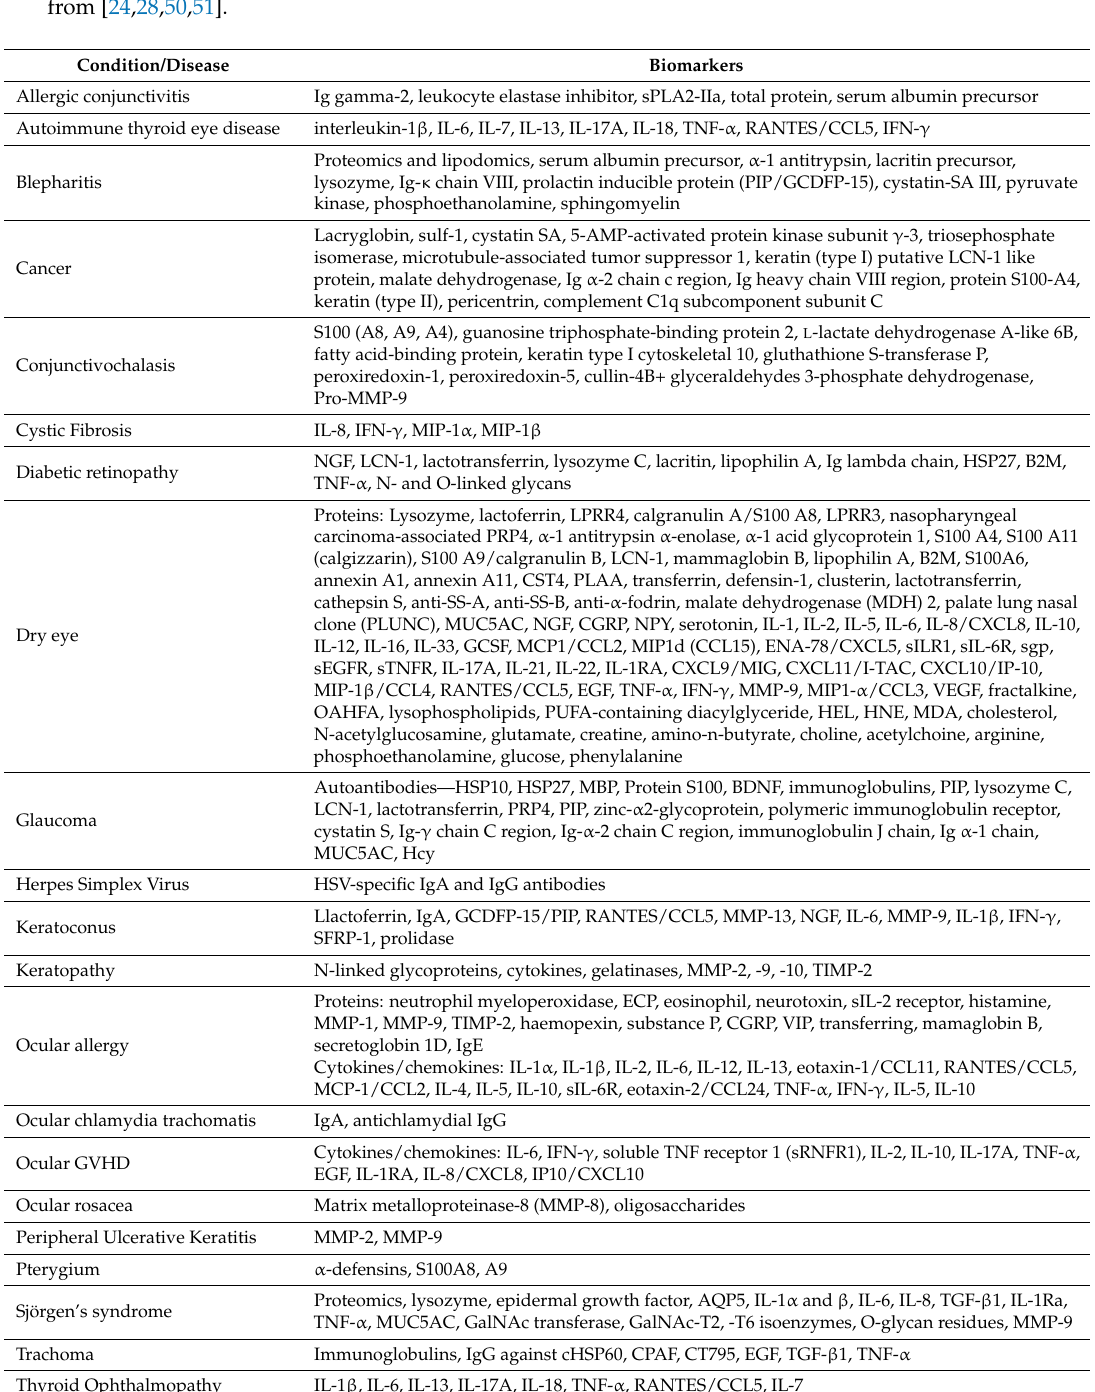
Table 3. Identified biomarkers in tear fluid associated with diseases and conditions. Adapted from